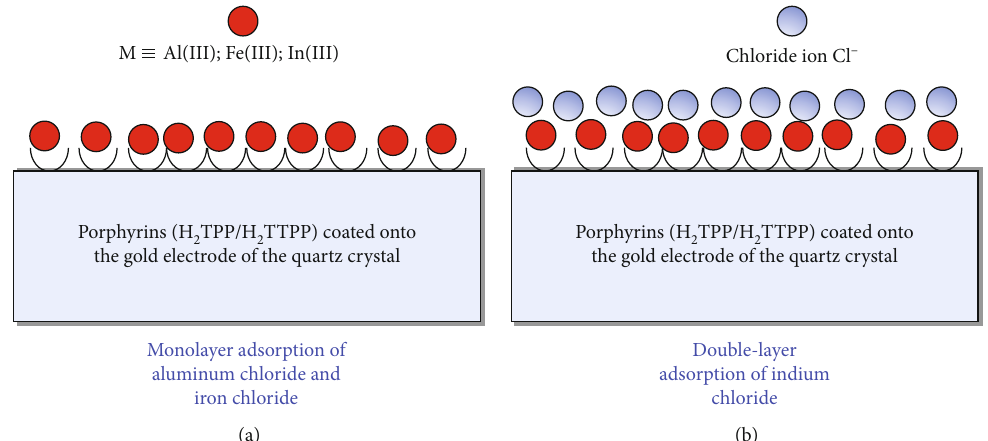
and FeCl and the LBL double-layer adsorption of InCl 3 3